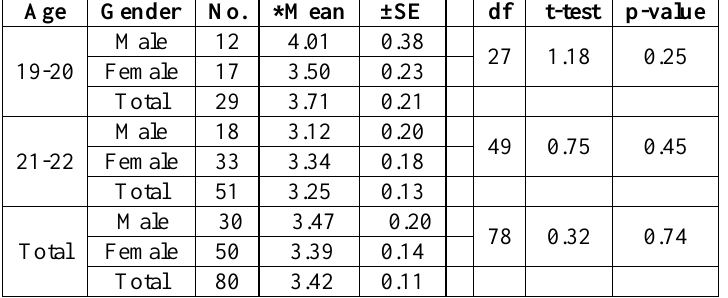
Table 3: Salivary zinc concentration (µg/dl) by age and gender Age Gender No. *Mean